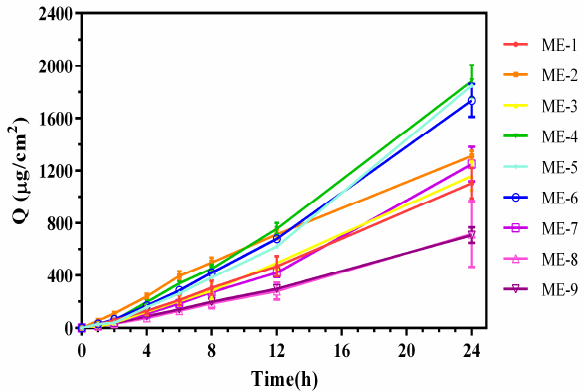
Figure 1. Pseudo-ternary phase diagram for TMP-ME. S&Cos is surfactant (Labrasol) and co-surfactant (Transcutol P); Oil is the oil phase (Maisine35-1); and circles show the compositions of TMP-MEs used for formulation optimization.